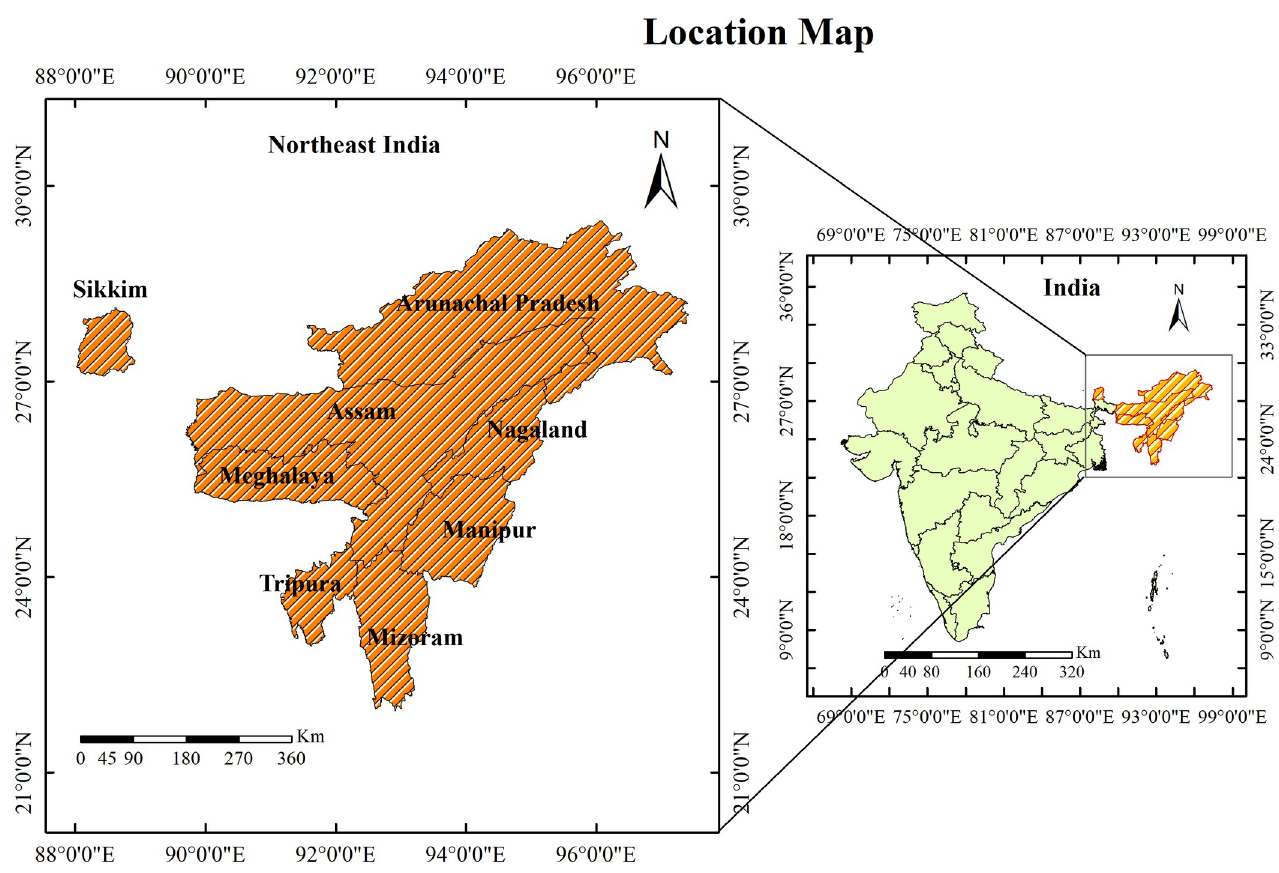
Fig 1. Map showing the location of the study